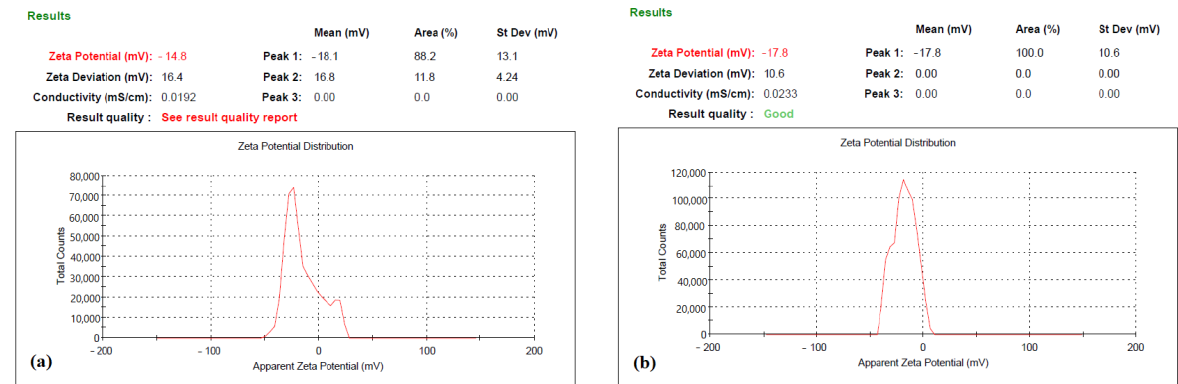
Figure 4. Zeta Potential of ( a ) blank LNPs and ( b ) silymarin LNPs, using Malvern Zetasizer, version 7.12 (Malvern, Worcestershire, UK).